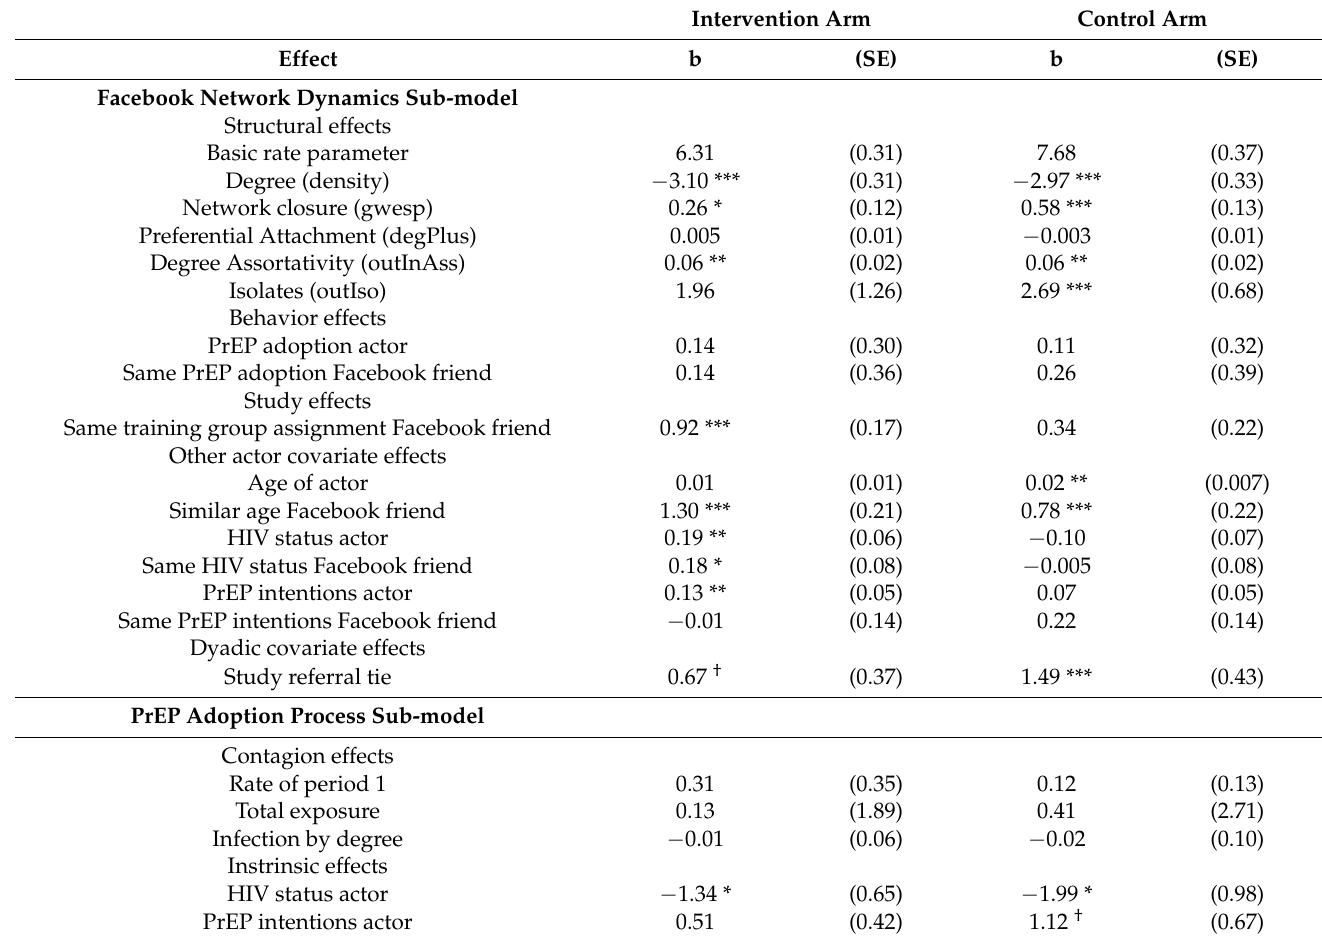
Table 4. Significance of parameter estimates of the Facebook network and PrEP adoption process